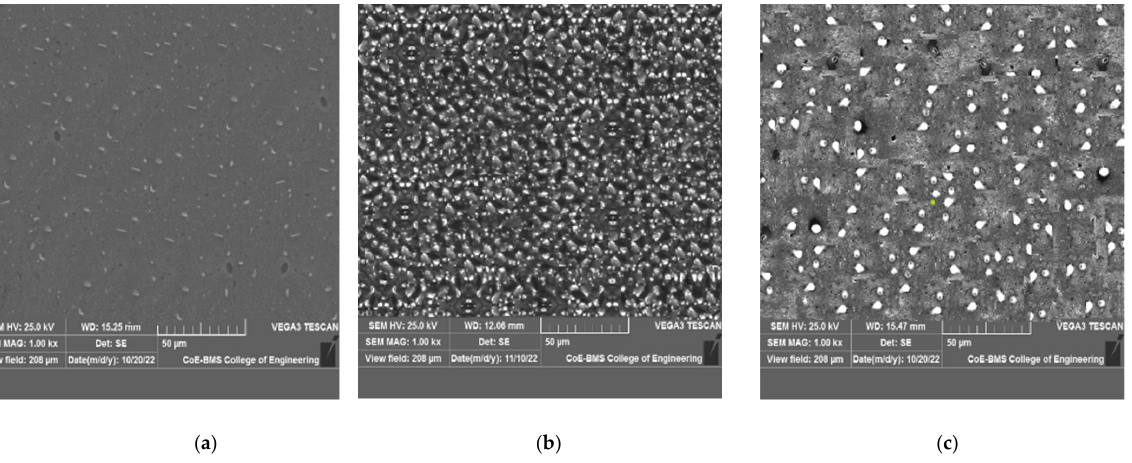
Figure 4. SEM images of a FSPed AA7075/ TiO 2 sample prepared at ( a ) 800 rpm and 35 mm/min, ( b ) 1000 rpm and 35 mm/min, and ( c ) 1000 rpm and 45 mm/min.